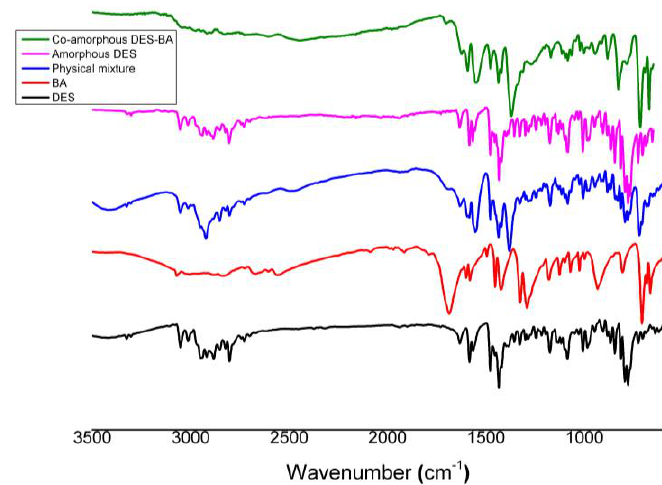
Figure 3. FTIR spectra of pure desloratadine (DES) (black line), pure benzoic acid (BA) (red line), physical mixture (blue line), pure amorphous DES (pink line), and co-amorphous DES–BA (green line).